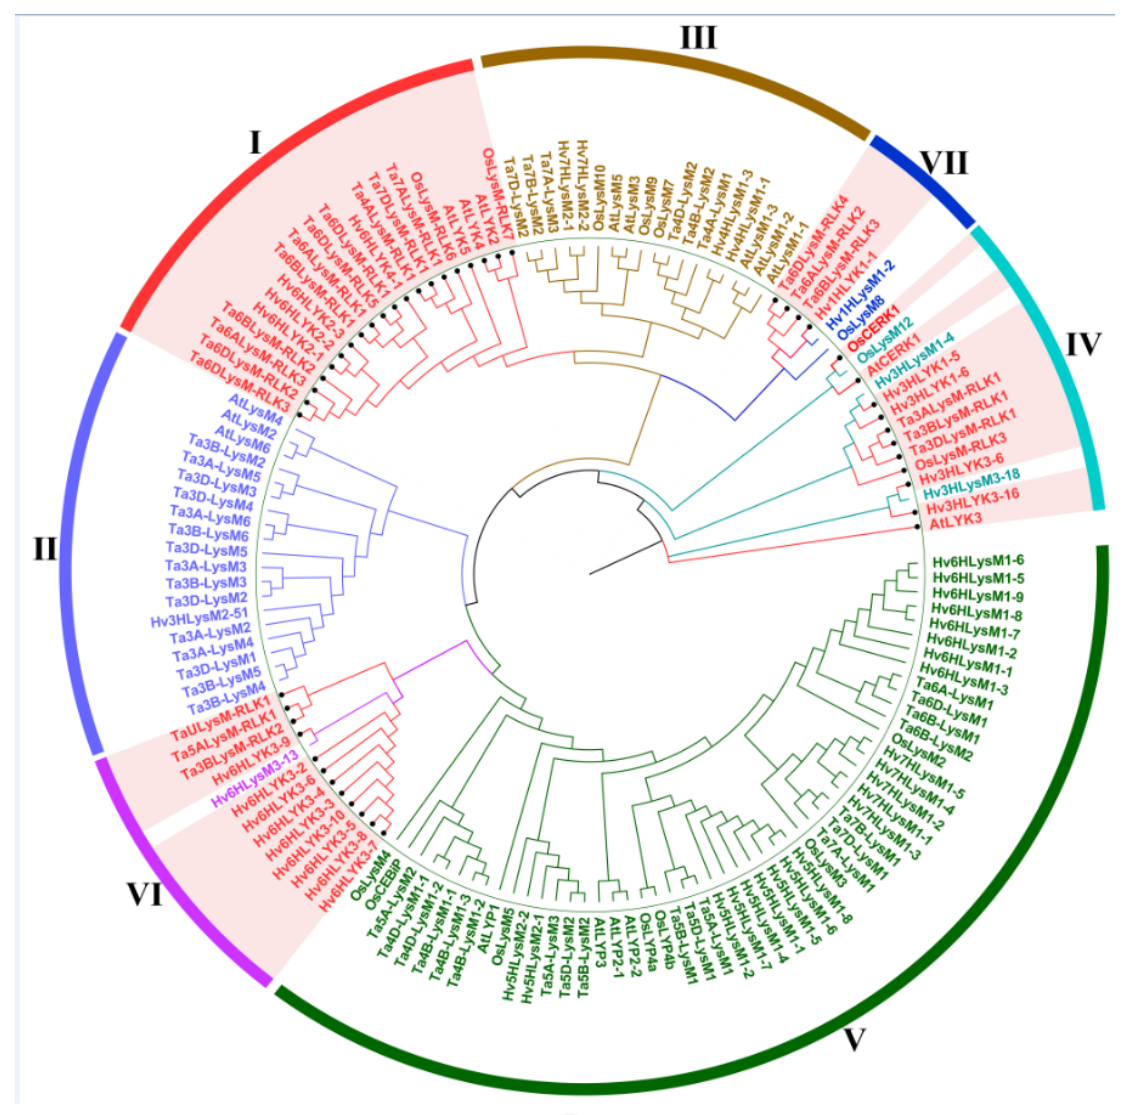
Figure 2. Phylogenetic tree of lysin motif (LysM)-containing receptor-like protein (LYP) and LysM-containing receptor-like kinase (LYK) in wheat, barley, Arabidopsis , and rice. Different colored arcs represent different groups of LYP and LYK. The red colored genes are LYKs distributed in different groups. LYK and LYP from Arabidopsis , barley, wheat, and rice are labeled with the prefix ‘At’, ‘Hv’, ‘Ta’, and ‘Os’, respectively.